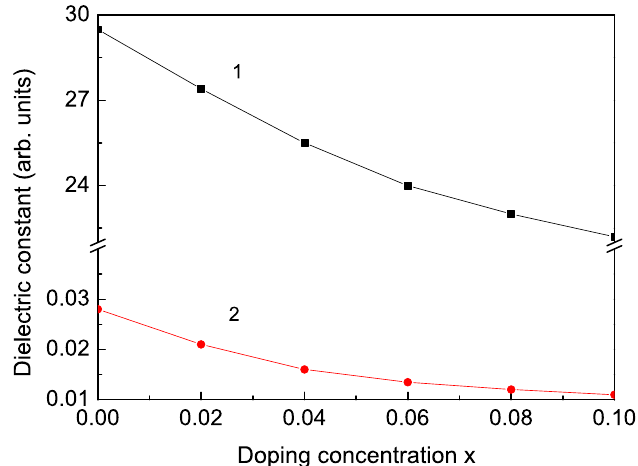
Figure 4. (Color online) The real (curve 1) and imaginary part (curve 2) of the dielectric constant (cid:101) as function of the Pr doping concentration in CCO NP, N =